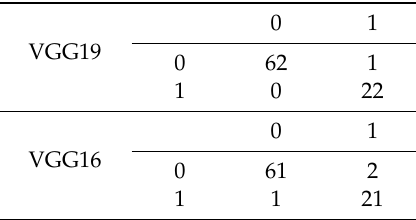
Table 7. Confusion matrix of the test cases predicted for mild-ROP, denoted as 0, and severe-ROP, denoted as 1, by the VGG19 and VGG16 models.